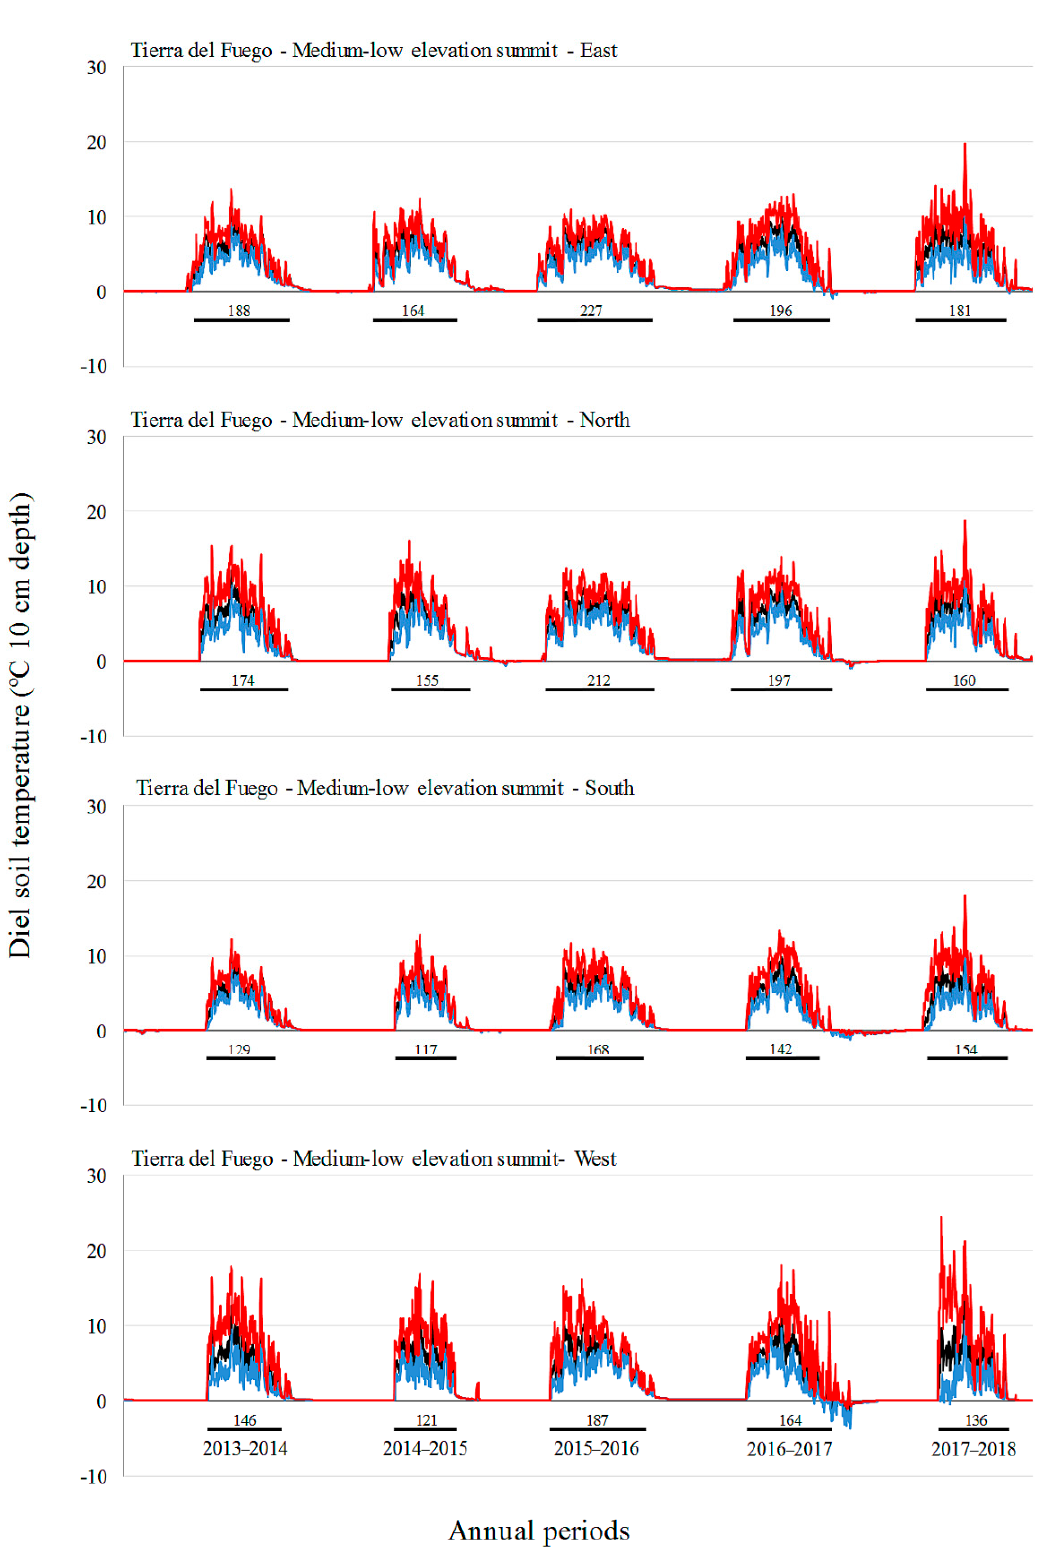
Figure A5. Diel soil temperature ( ◦ C) variation at 10 cm depth during the five studied annual periods (2013–2014 to 2017–2018) on medium-low elevation summit in Tierra del Fuego, showing separately different cardinal aspects (east, north, south, west). The length of the growing season is also indicated with horizontal black bars (numbers represent days). Black = mean temperature; blue = minimum temperature, and red = maximum temperature.